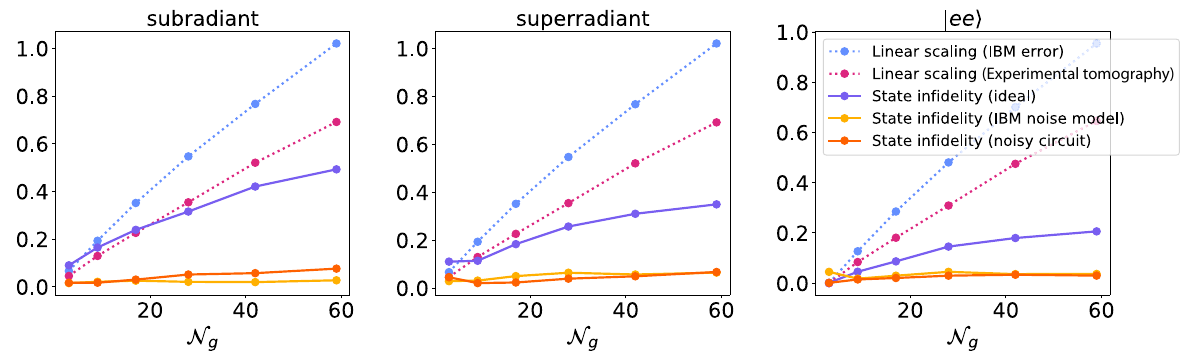
FIG. 4. The scaling of the error as a function of the number of CNOT gates in the algorithm N g during the simulation of the collective dynamics shown in Fig. 2. The markers indicate the steps of the collision model. The dotted light blue and magenta lines show the linear scaling of, respectively, the IBM gate error and the experimental average gate infidelity, given in Fig. 3. The continuous violet line shows the infidelity between the experimental state and the ideal one. The error bars for the latter quantity are obtained as the standard deviations of 100 realizations of a random sample of the state-tomography data via bootstrapping and they are within the markers. The continuous orange line shows the infidelity between the experimental state and the state simulated on the noisy circuit. The continuous yellow line shows the infidelity between the experimental state and the state simulated via the IBM noise model.